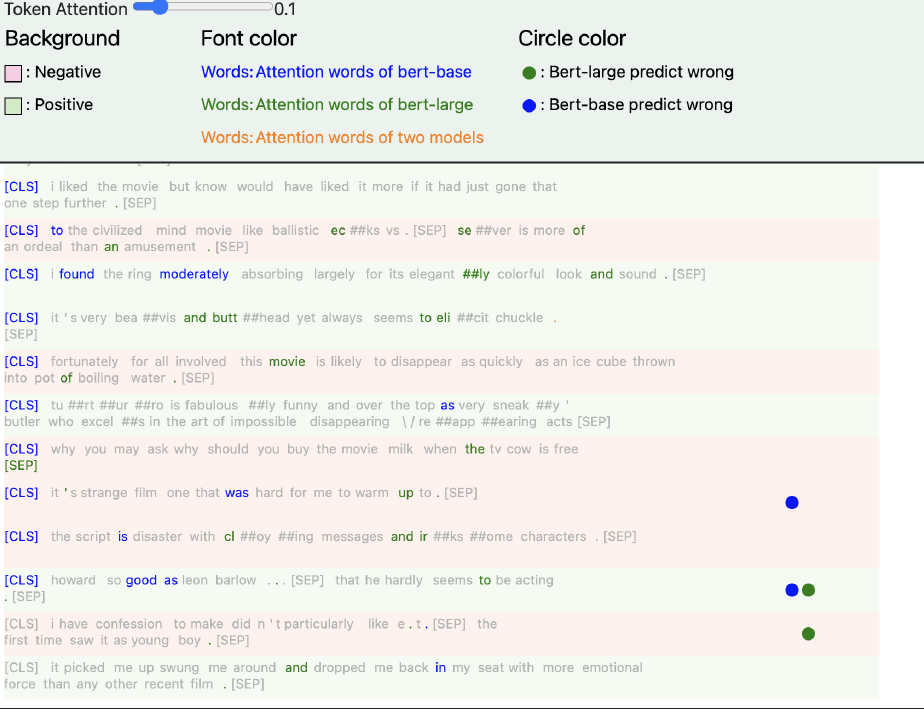
Figure 12. Attention view. The view mainly presents the attention words of selected heads of the [CLS] token of instances in the two models.